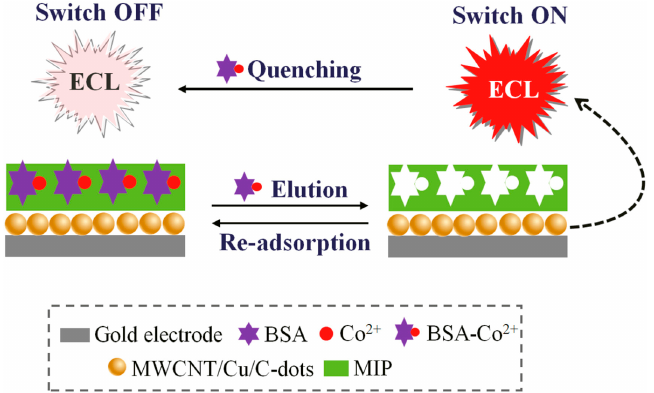
Figure 9. Dual-recognition switch sensor for the detection of Co 2+ [63]. Copyright 2019 Elsevier (Amsterdam, The Netherlands).